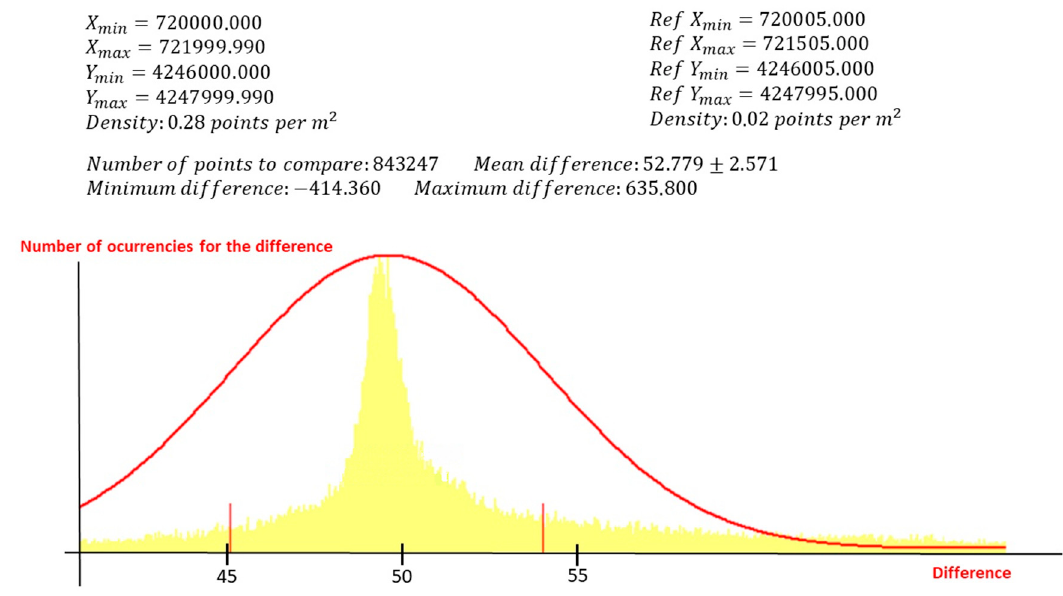
Figure 9. Details of the hypsometric analysis carried out.